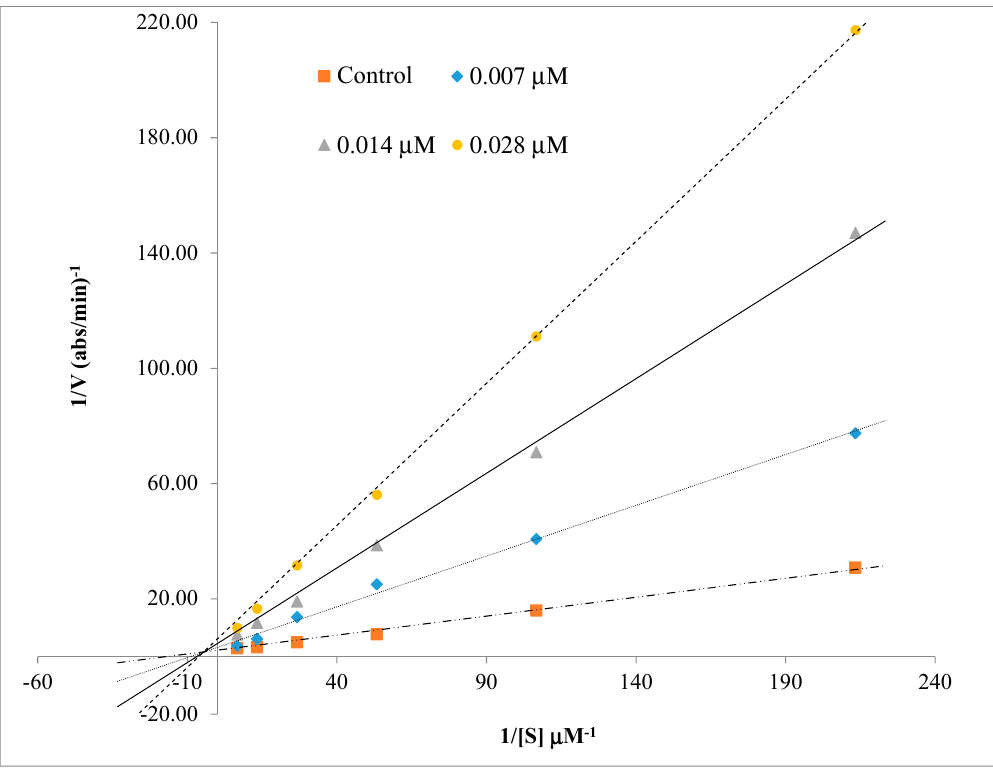
Figure 2. Lineweaver–Burk plot for the inhibition of human butyrylcholinesterase (BChE) by compound 4n at different concentrations of substrate butyrylthiocholine iodide (BTCI) .